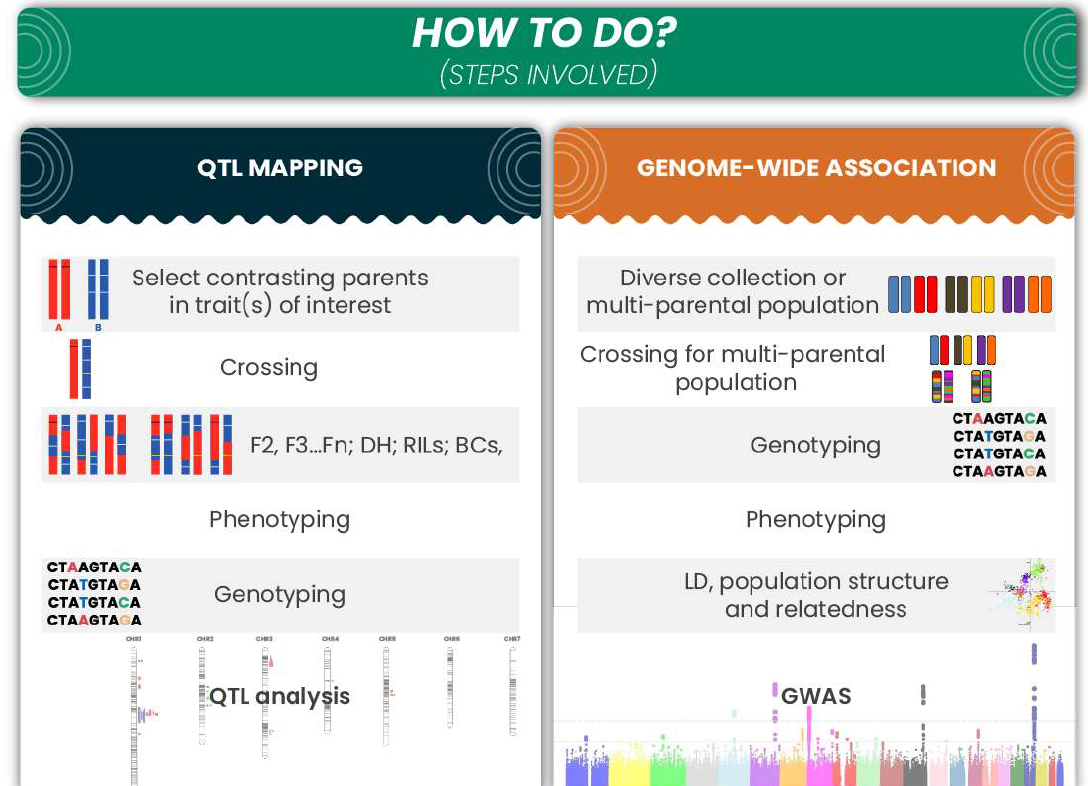
Figure 2. Brief description of the major steps involved in QTL mapping and GWAS.